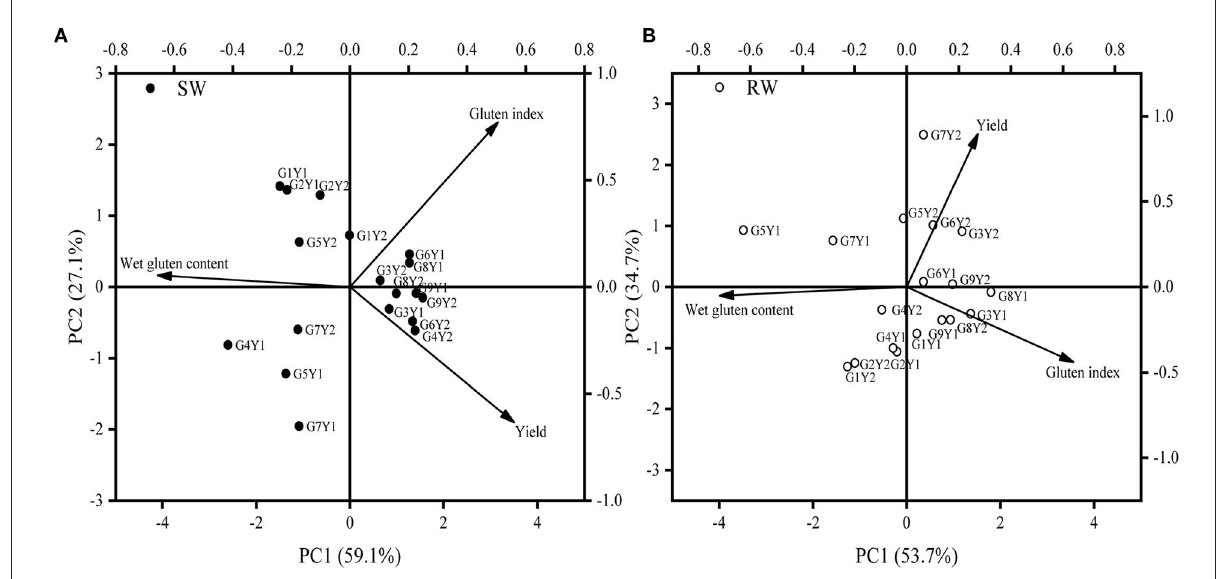
FIGURE4 The PCA on yield and grain protein quality of nine wheat genotypes in two wheat cropping systems and two cropping years. All values were measured with three replications ( n = 3). The vectors represent the loading scores of variables for PC1 and PC2. SW, soybean-wheat cropping